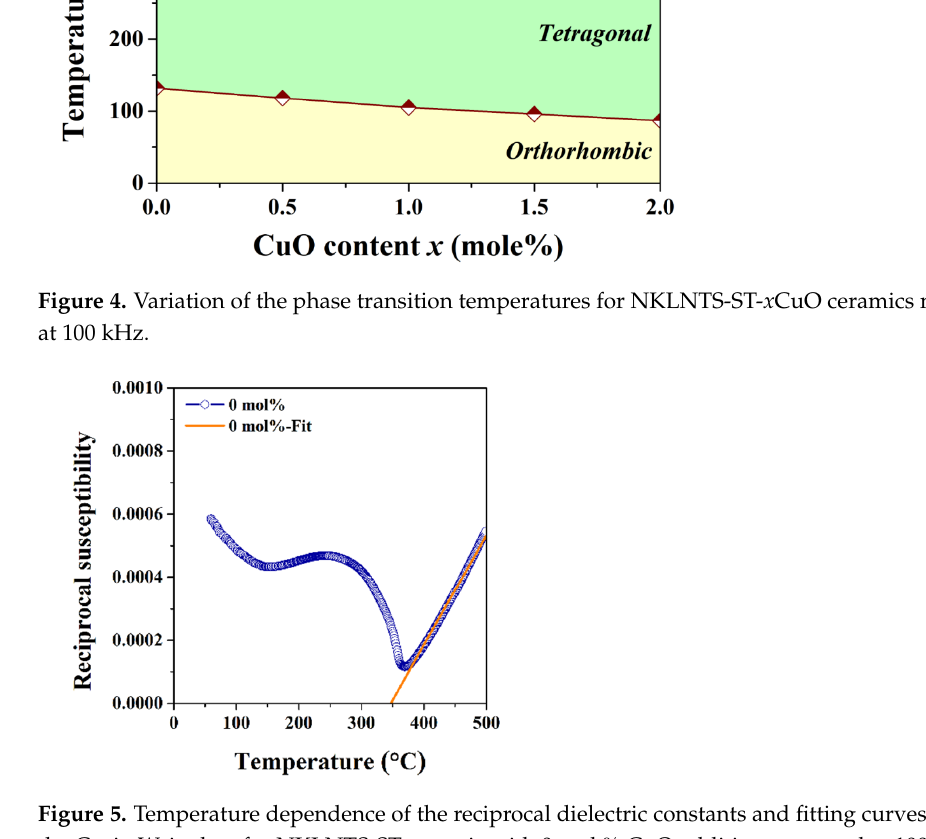
Figure 5. Temperature dependence of the reciprocal dielectric constants and fitting curves by using the Curie-Weiss law for NKLNTS-ST ceramic with 0 mol % CuO additive measured at 100 kHz. Table 2. Empirical parameters of the of NKLNTS-ST- x CuO ceramics.